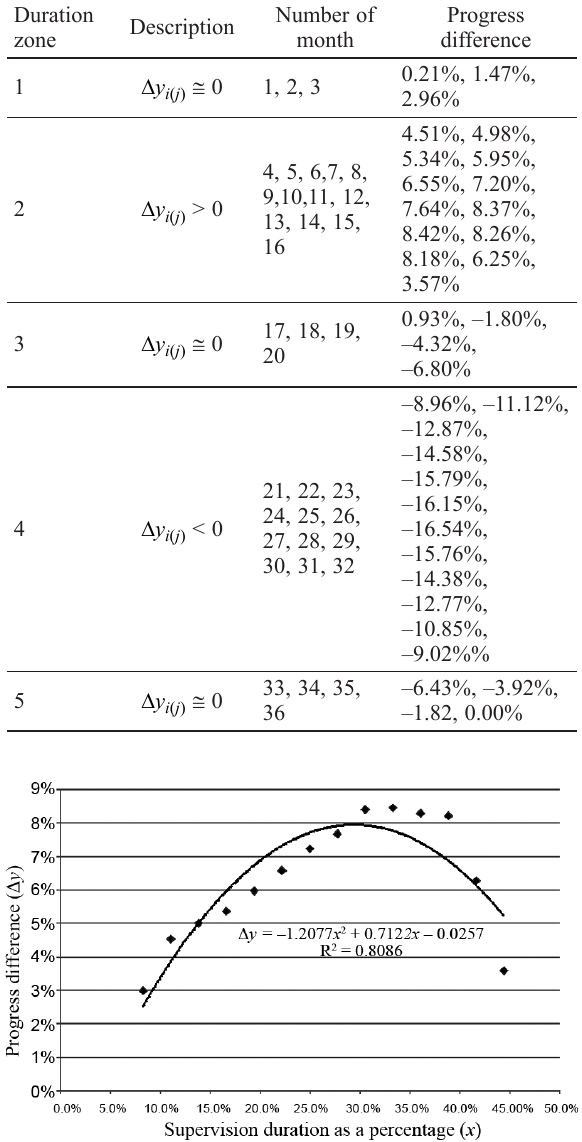
Table 5. Progress differences classified in each zone of project A1